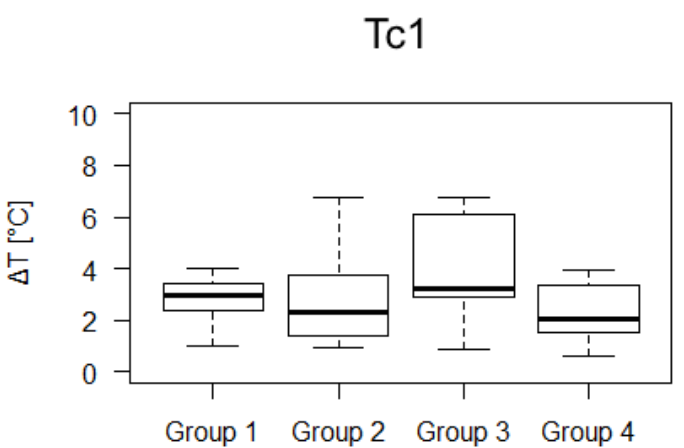
Figure 5 . Boxplot showing the largest temperature variation (ΔT) at Tc1 in the four groups. Among the secondary outcome measures, the largest temperature variation at Tc2 showed a median of 1.9 °C (IQR 1.5–3.2 °C) in Group 1, which was not statistically differ-